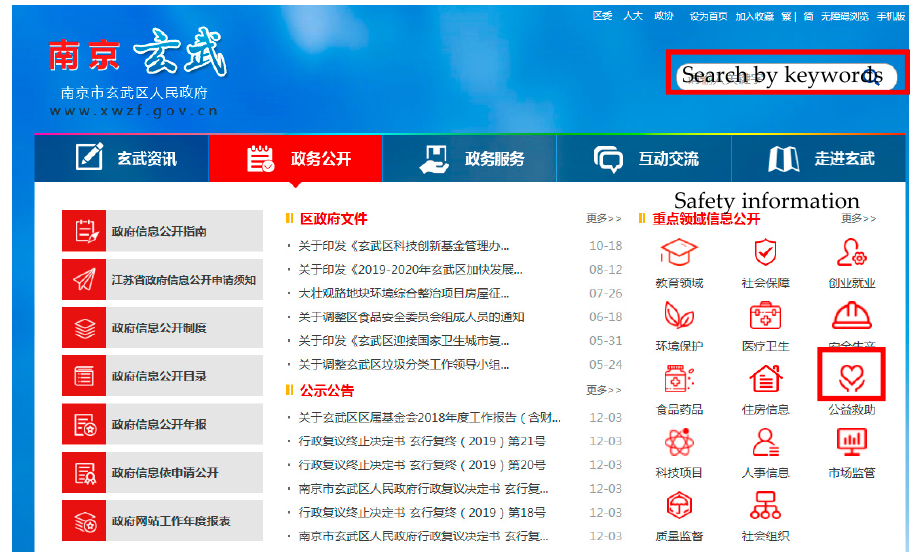
Figure 1. The interface of the government website to illustrate the searching process.